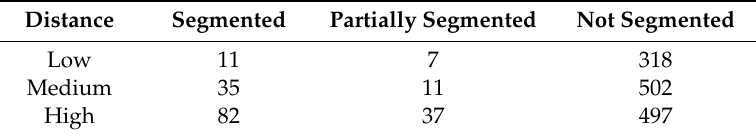
Table 5. Results of land segmentation using the Watershed algorithm.